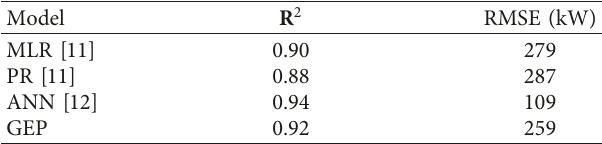
Table 5: Comparison of results obtained by applying different forecasting